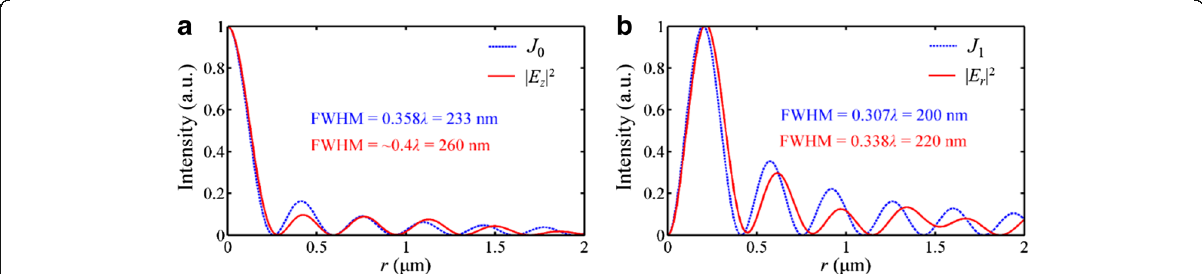
Fig. 11 Intensity profiles of the NRPL in the focal plane under the radially polarized incident light. a The distribution of | E z | 2 resembles the zero- order Bessel function J 0 . b The distribution of | E r | 2 resembles the first-order Bessel function J